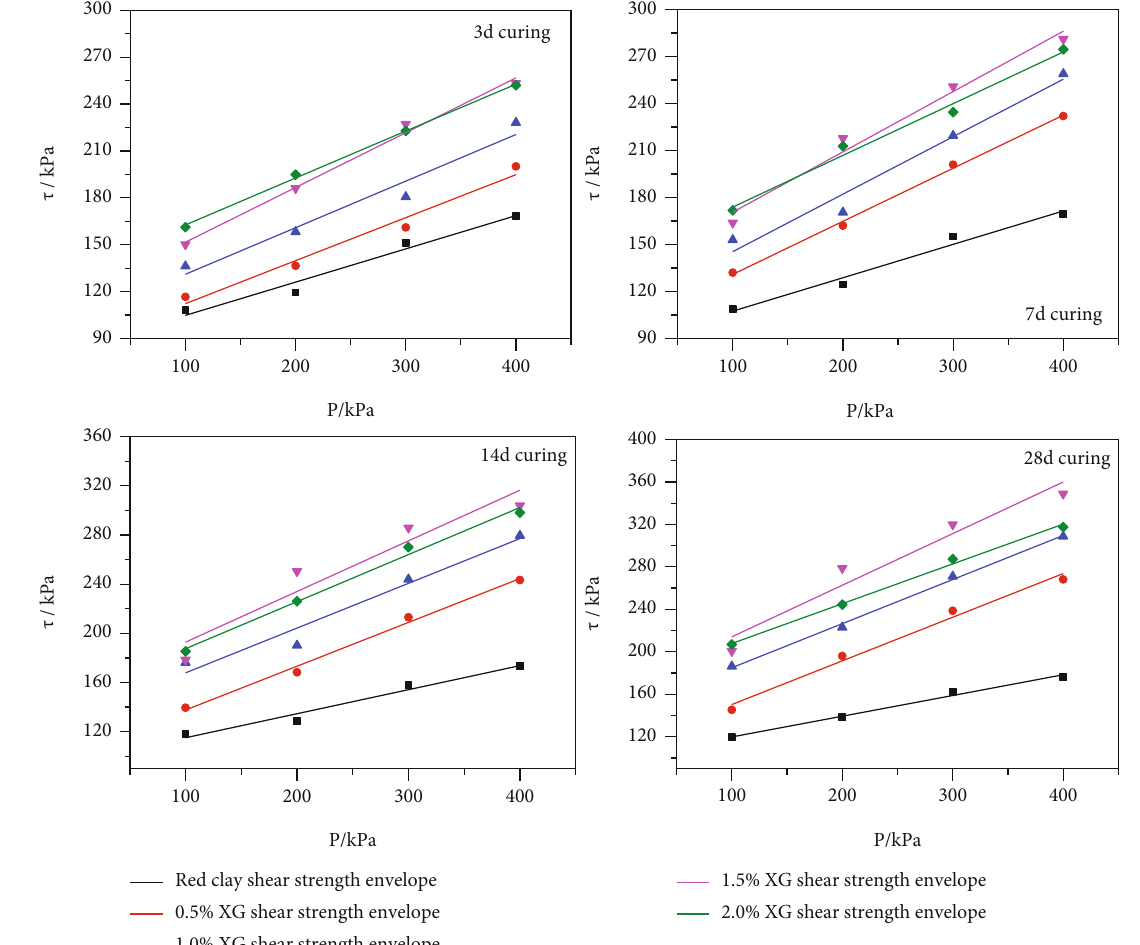
Figure 11: Strength envelope for curing for 3, 7, 14, and 28